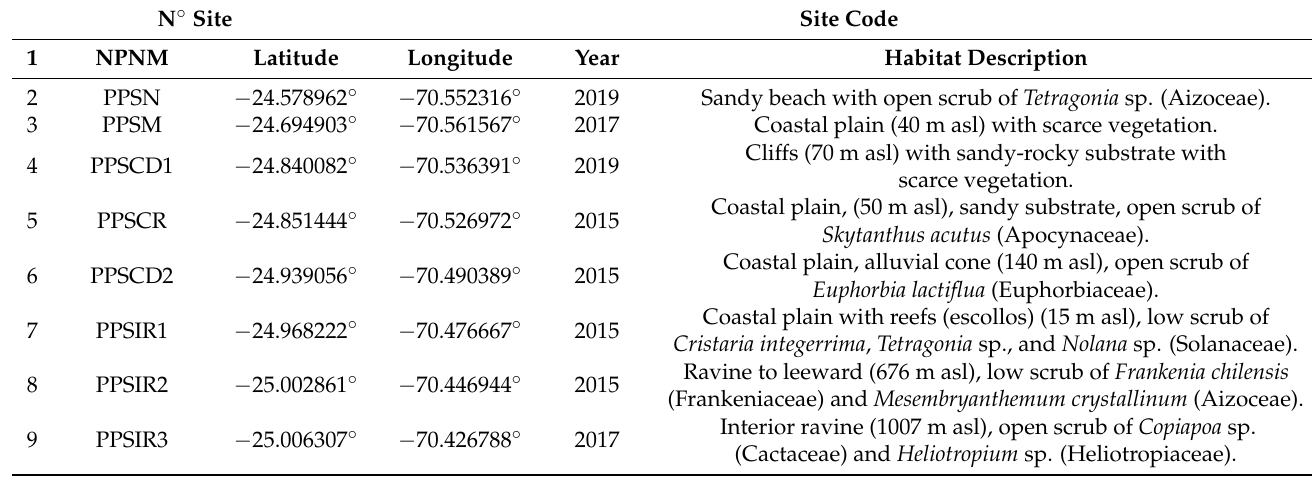
Table 1. Habitat description and geographical location for the studied sites in Paposo (Antofagasta Region, Chile). N ◦